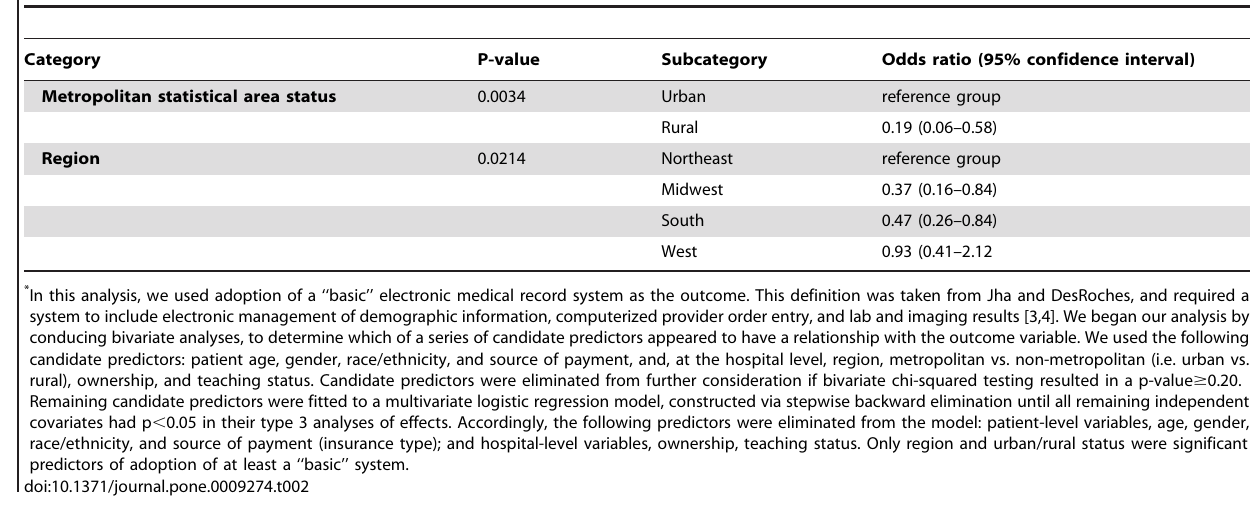
Table 2. Predictors of Adoption of at least a ‘‘Basic’’ Electronic Medical Record